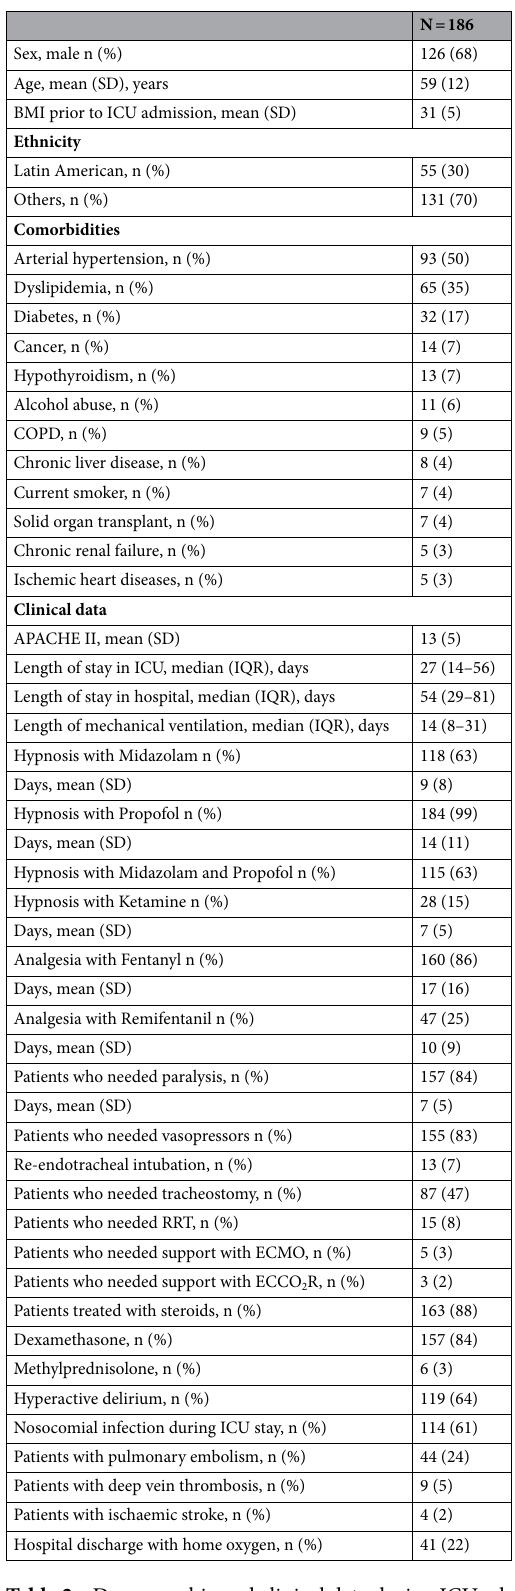
Table 2. Demographic and clinical data during ICU admission. BMI body mass index, COPD chronic obstructive pulmonary diseases, APACHE II acute physiology and chronic health evaluation II, SD standard deviation, ICU intensive care unit, IQR interquartile range, RRT renal replacement therapy, ECMO extracorporeal membrane oxygenation,